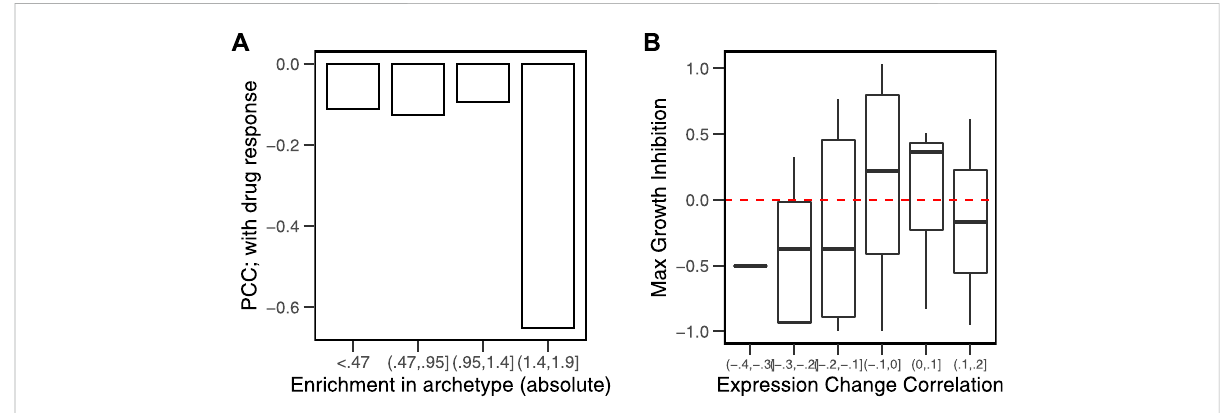
FIGURE 6 Correlationbetweenhallmarkenrichmentinarchetypesandinresponsetodrugperturbations.Asetofsixarchetypeswasestimatedfromgene